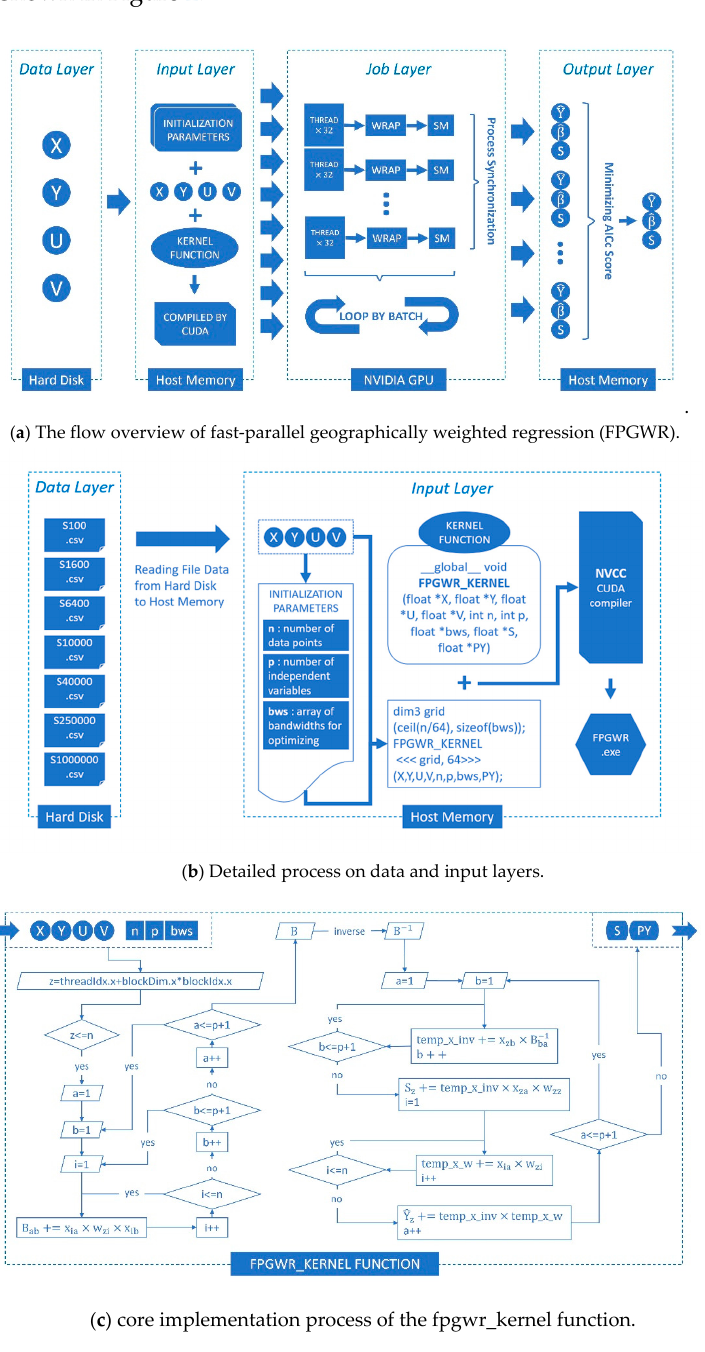
Figure 2. Flow diagram of FPGWR on CUDA ( a – c ).